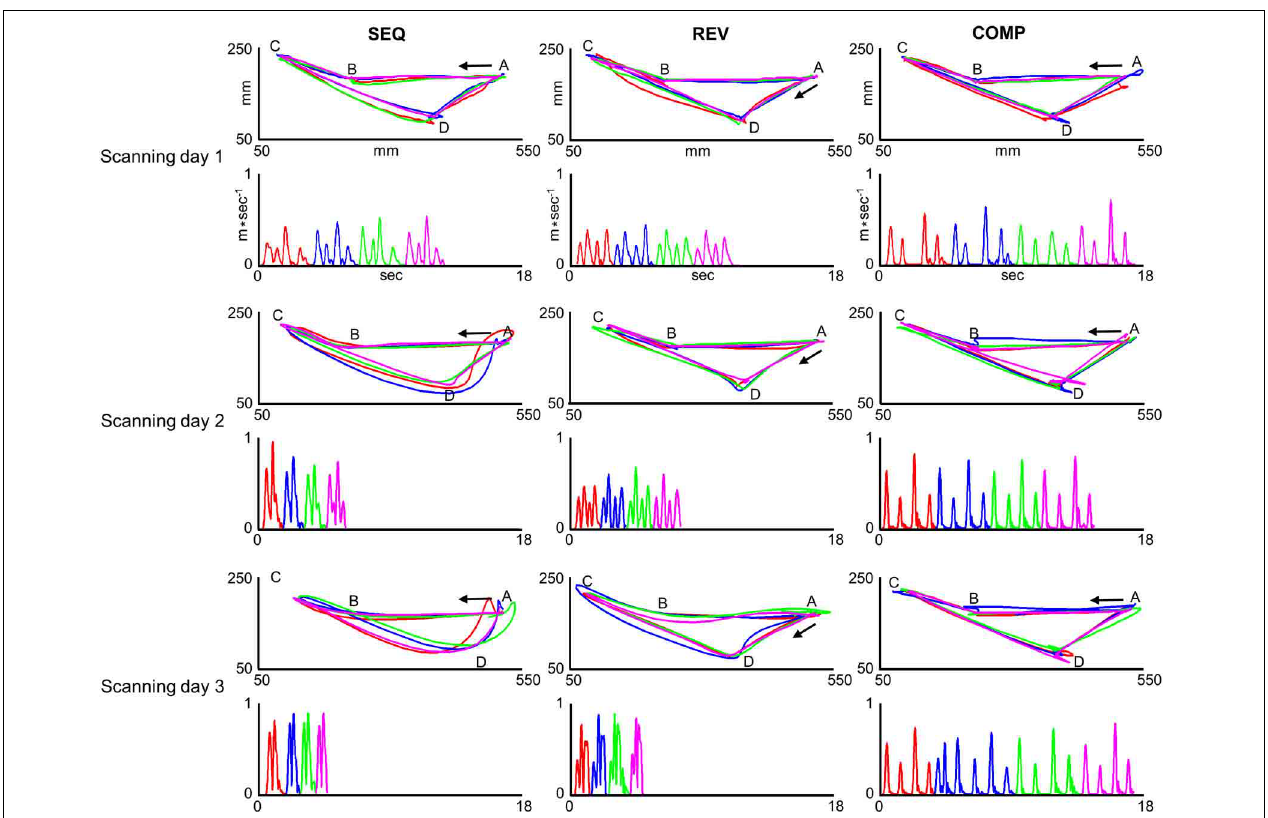
FIGURE 4 | Trajectories generated inside the MRI scanner by one co-articulating subject (subject #3). For each training condition (SEQ, REV, and COMP) and scanning day (scanning day 1, 2, and 3) the red, blue, green, and magenta plots depict four representative paths (upper panels) and their respective tangential velocity profiles (lower panels) generated in two consecutive sub blocks. In order to allow for a